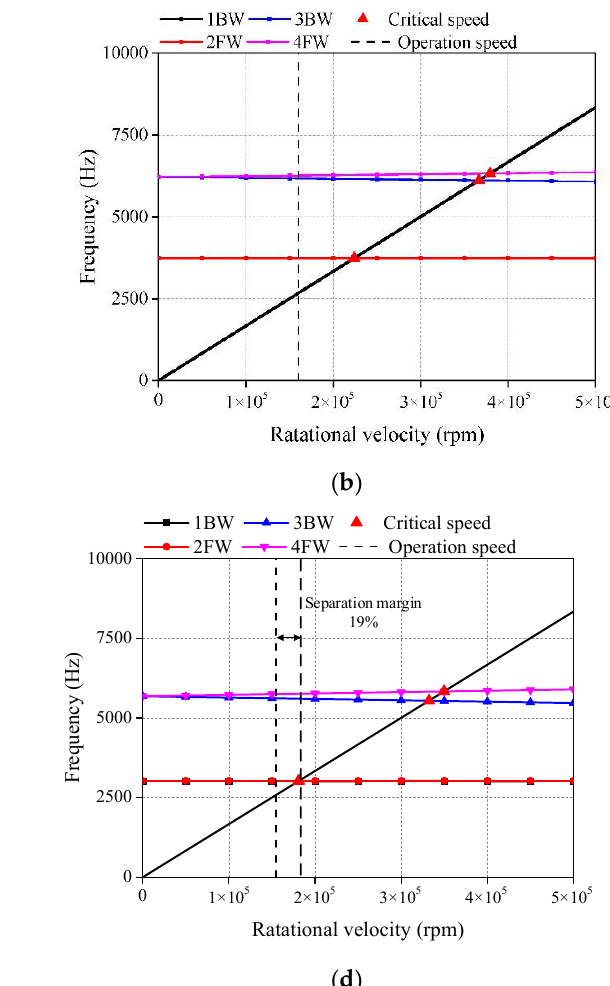
Figure 6. Influence of the critical speed on bearing stiffness.